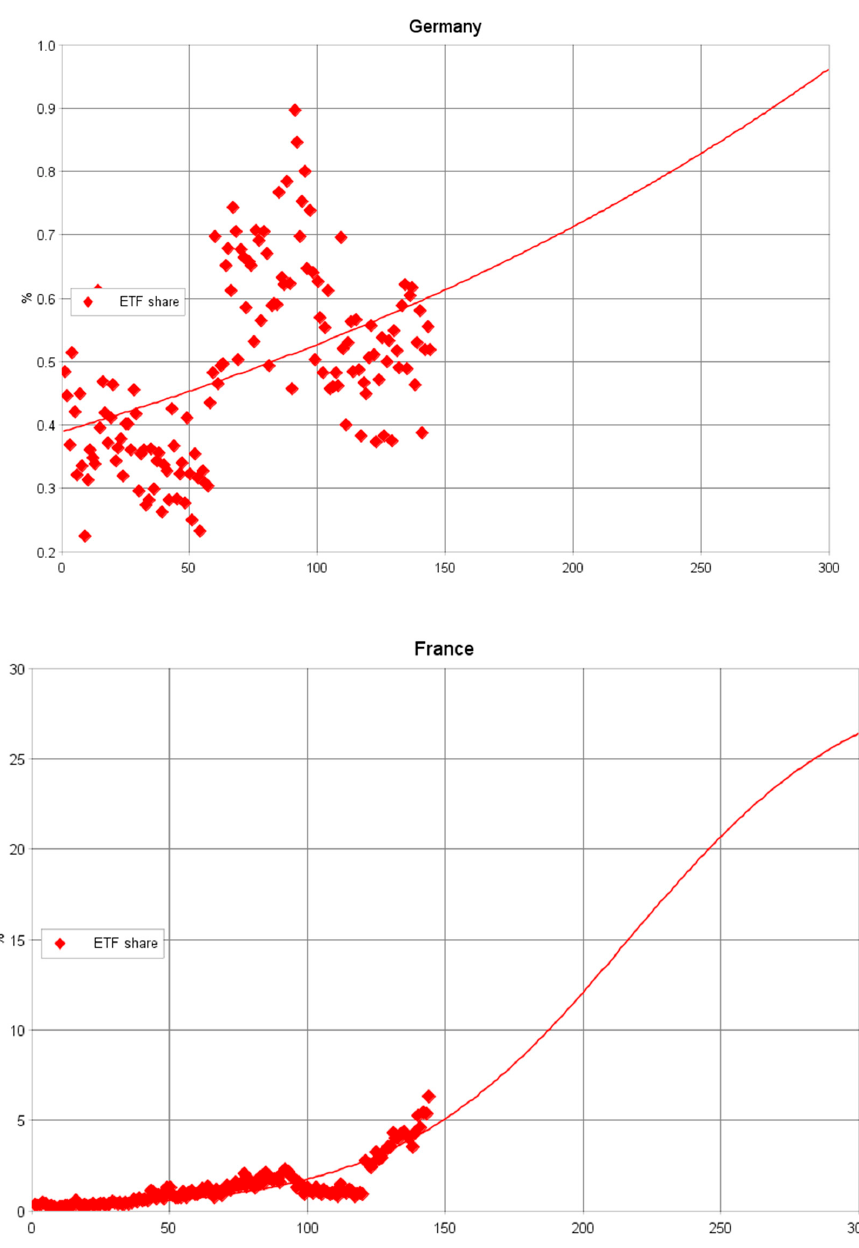
Figure A2. Current and predicted ETF diffusion patterns. Graphs and forecasts prepared using IIASA software.